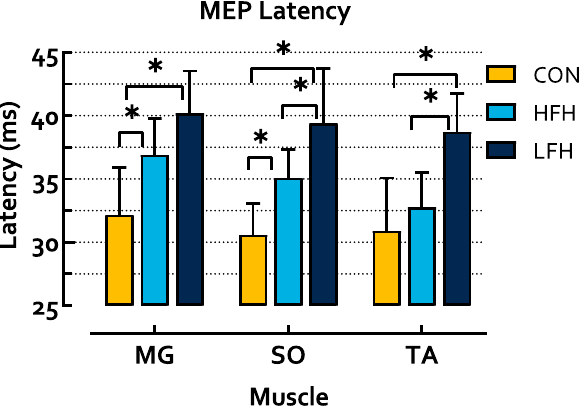
Figure 4. MEP latency in the shank muscles during walking. CON exhibited significantly shorter latencies than both HFH and LFH individuals. HFH exhibited shorter latencies than LFH in the SO and TA. Asterisks denote a p < 0.05.